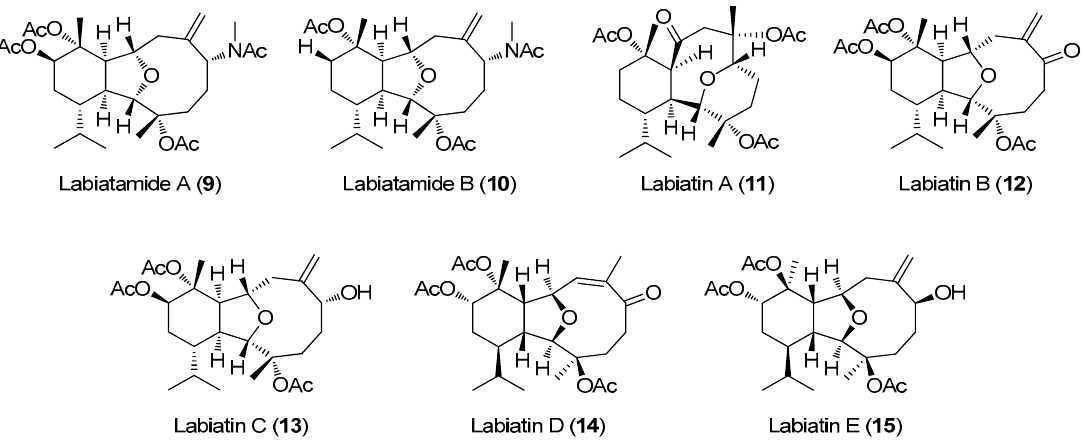
Figure 6. Labiatamides A ( 9 ) and B ( 10 ) and labiatins A–E ( 11 – 15 ) isolated from E. labiata .